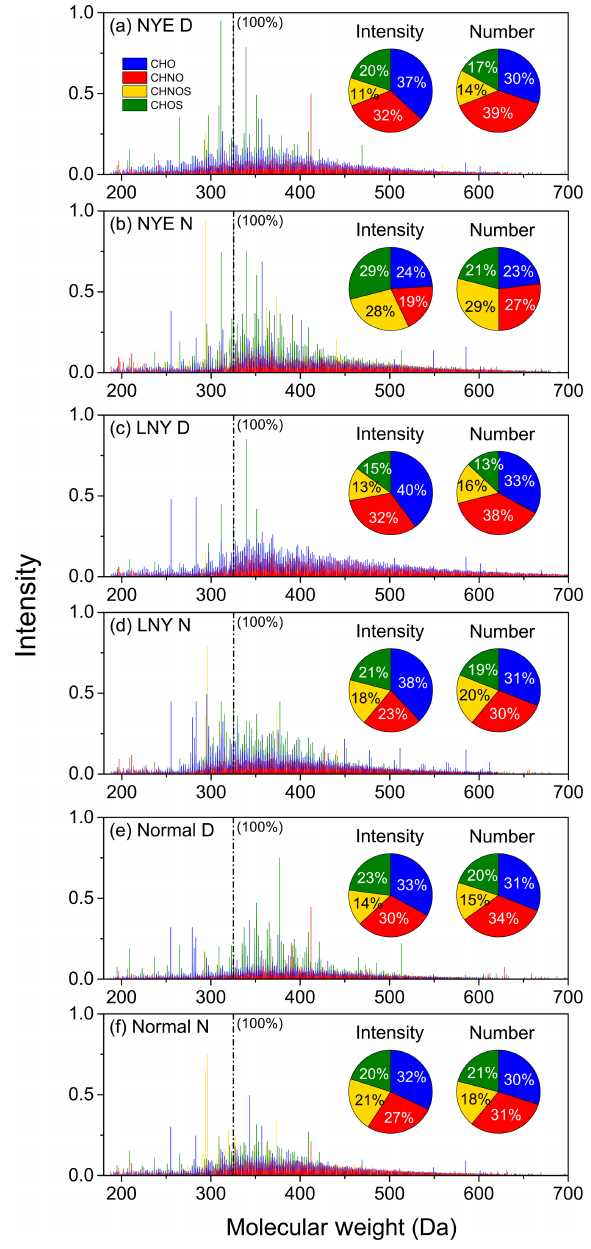
Figure 1. Distribution of relative intensity, number, and inten- sity fractions of CHO, CHNO, CHOS, and CHNOS compound in WSOC isolated from aerosol samples detected in FT-ICRMS. The detailed molecular characteristics of CHNOS are discussed in an- other